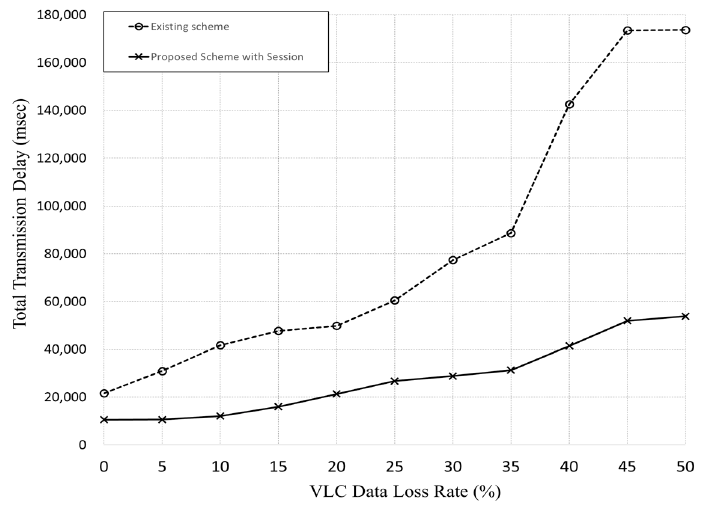
Figure 25. Total transmission delays for different VLC data loss rates.